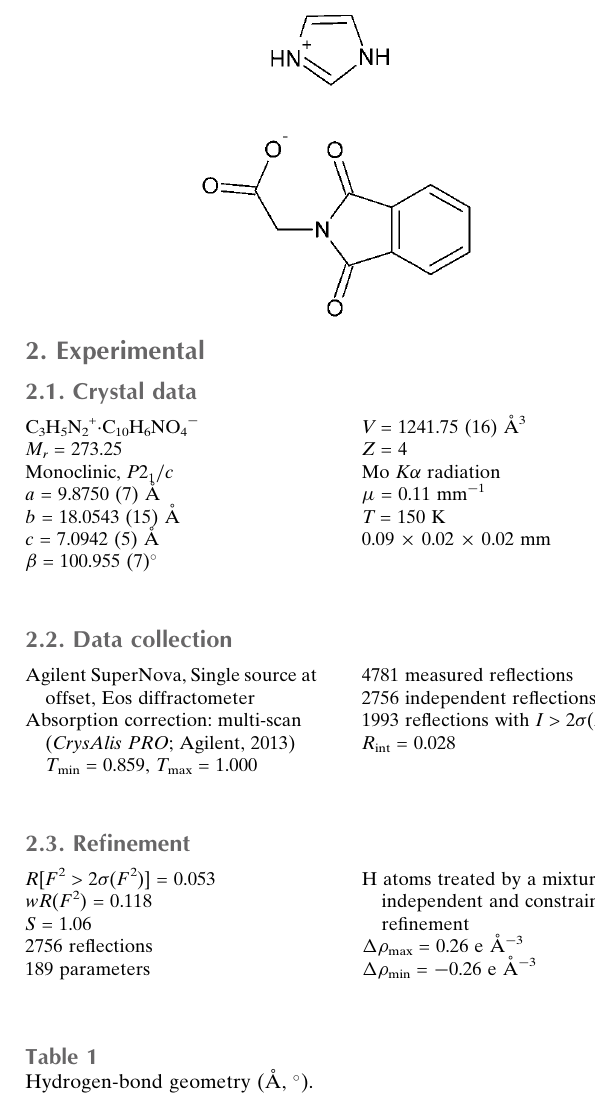
Hydrogen-bond geometry (A˚ , (cid:4)